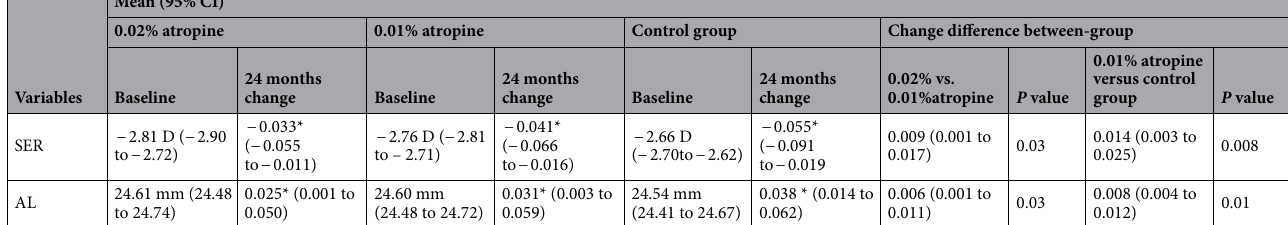
Table 2. Change and change difference of SER and AL in three groups over 2-year. CI: confidence interval. SER: spherical equivalent refractive error; AL: axial length. Change: represents the slope of SER(D/month) and AL (mm/month) over time for three groups. Change difference: represents the difference in slope of SER and AL over time between each two groups. A generalized additive mixed model was used to estimate the longitudinal trend from baseline to 24 months. A significant increase was shown in change in SER and AL in three groups from baseline to 24 months. *Represents: changes were significantly different.